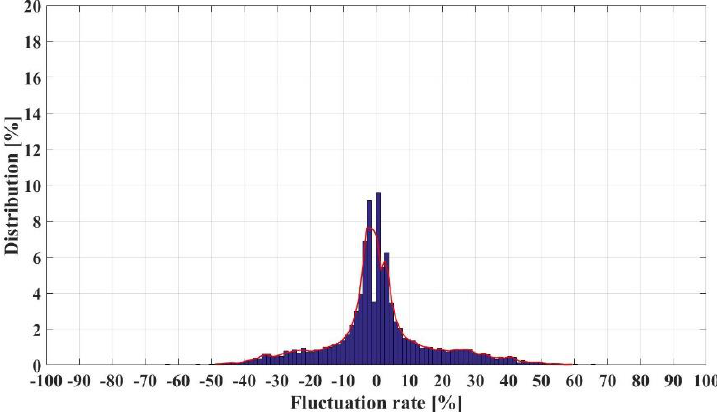
Figure 8. Field test result 1: histogram of wind power output.